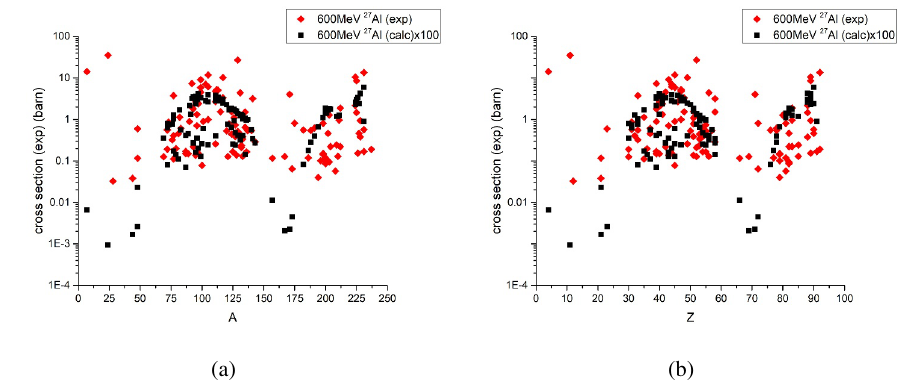
Figure 6: Graph of the cross sections for aluminum irradiated by 600 MeV